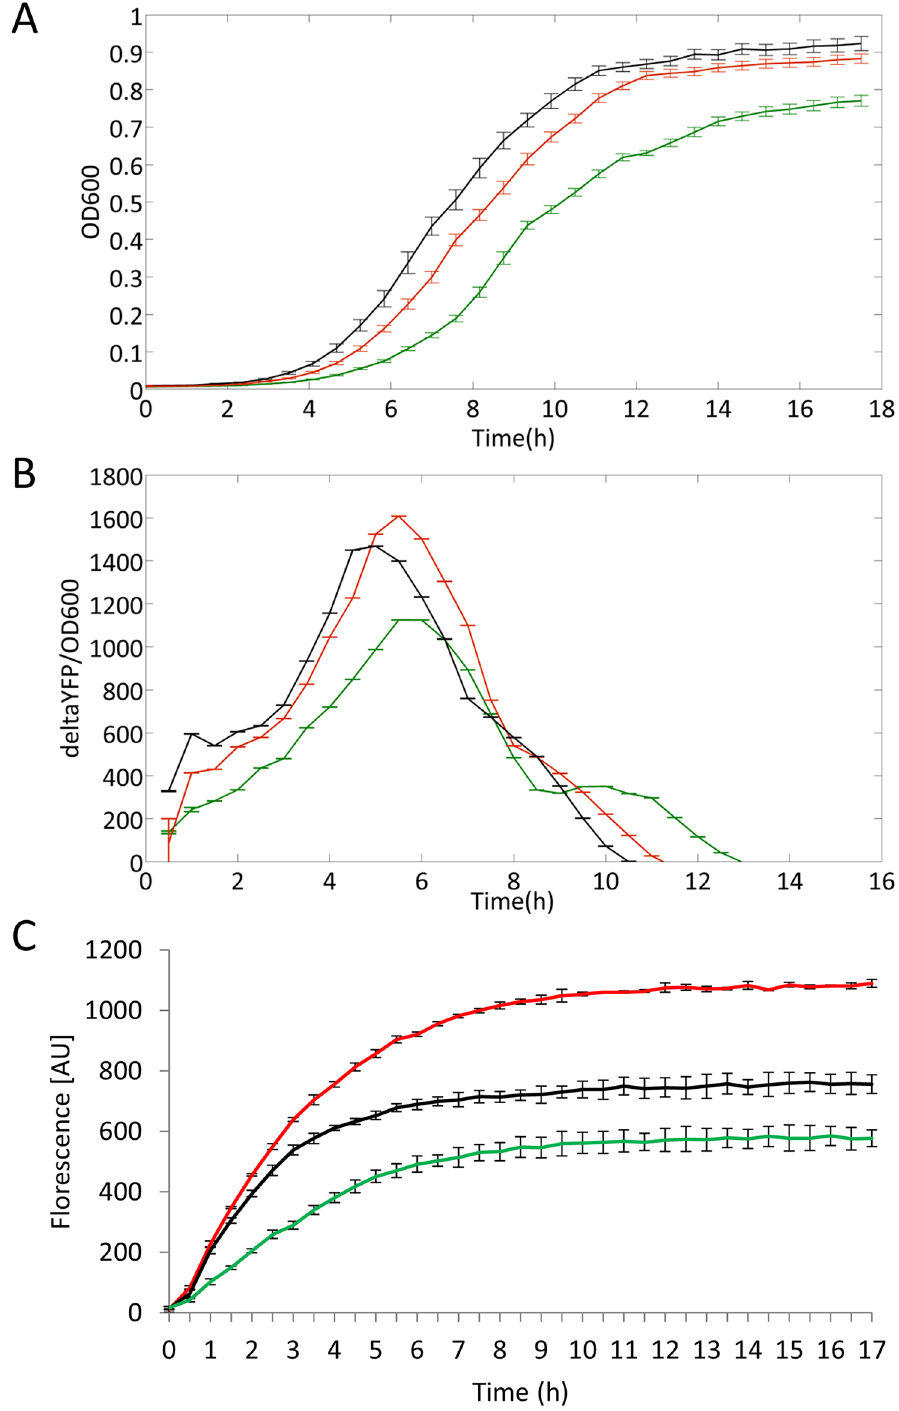
Fig 5. E . coli mutant strains harboring adenine at the orthologue of mitochondrial 16S rRNA position 947 showed impaired growth and protein synthesis. ( A ) Strains harboring a guanine (black line) or a thymine (red line) grew faster than strains harboring an adenine (green line). Lines represent an average with standard deviation of 42 repeated experiments. ( B ) E . coli harboring either a thymine (red line) or a guanine (black line) translated YFP more efficiently than E . coli strains harboring an adenine (green line). Lines represent average with standard deviations of 42 repeated experiments. ( C ) In vitro green fluorescent protein (GFP) synthesis of the different samples was measured over time by fluorescence excitation. Elevated GFP